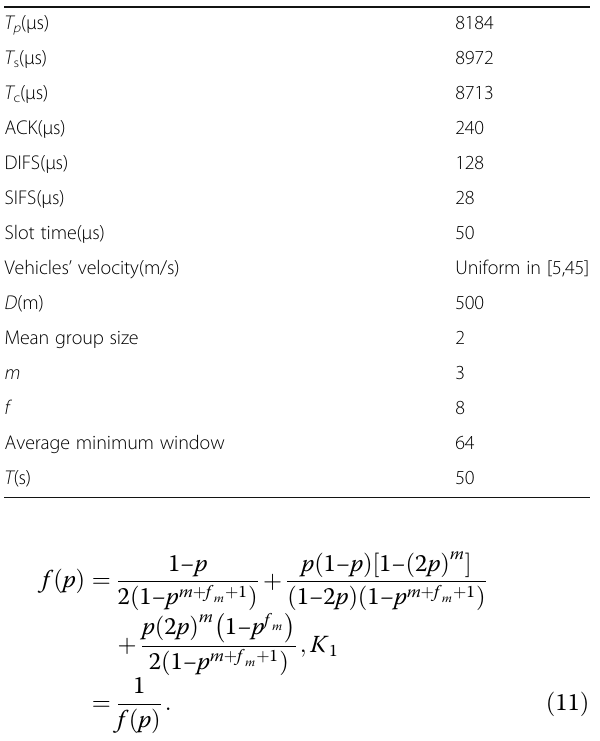
Table 3 Parameters used in the simulation